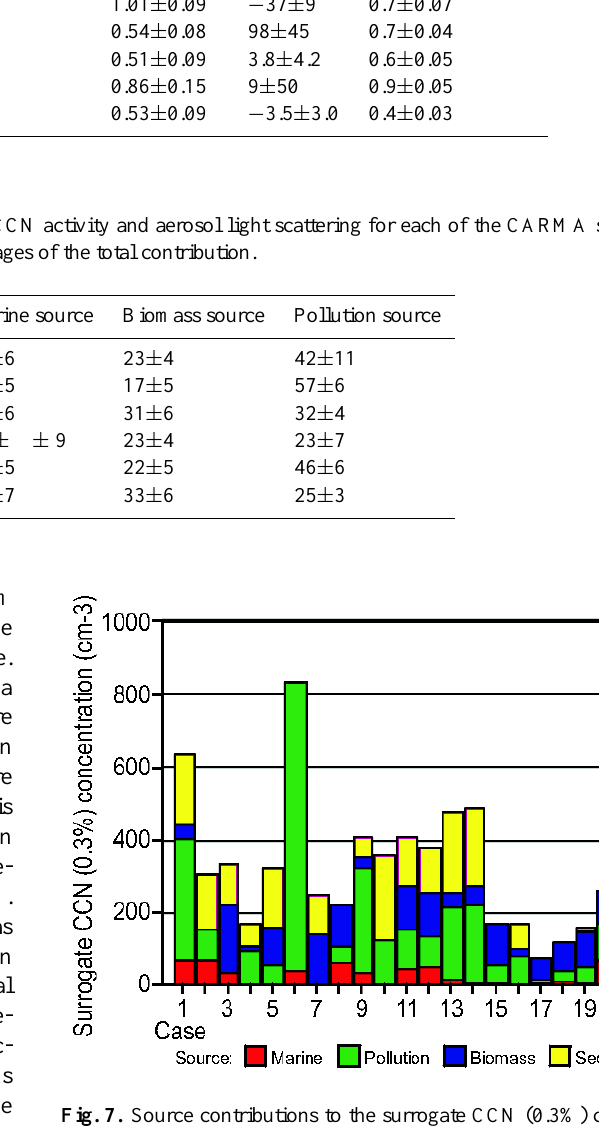
Fig. 7. Source contributions to the surrogate CCN (0.3%) concen- tration of each of the four sources to each sample taken during the CARMA II study. The samples shown were taken consecutively between 1 and 21 July